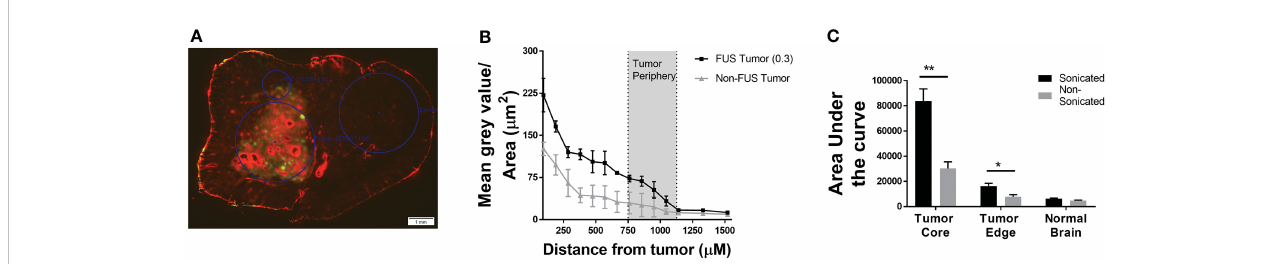
FIGURE 2 Differential permeability of TxRed (3kDa) is observed between tumor core and periphery in LIFU-disrupted tumors. (A) Fluorescent image showing TxRed accumulation within tumor (GFP). (B) Quantitative differential accumulation of TxREd between tumor core, edge and adjacent healthy brain. (C) Area under the curve for extent of brain accumulation of TxRed for non-sonicated and sonicated tumors and healthy brain following LIFU mediated BTB disruption. (p<0.001). * p<0.01, **